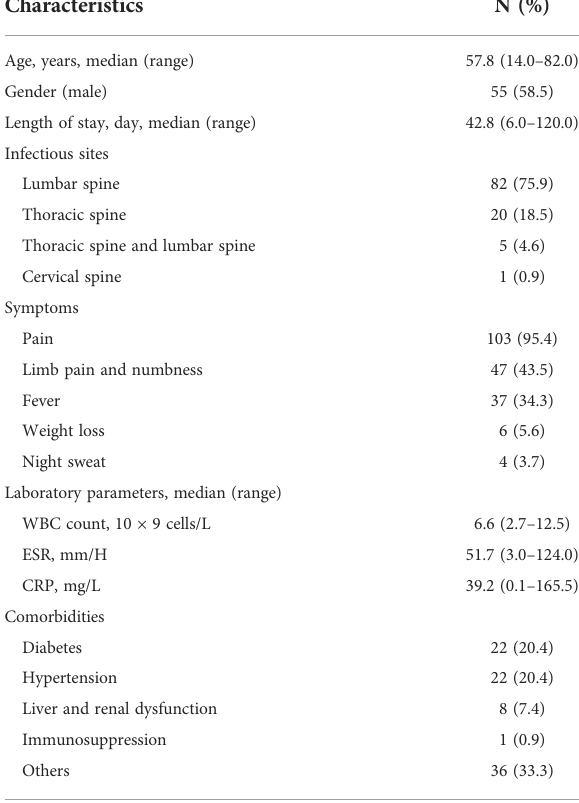
TABLE 1 Characteristics of 108 patients enrolled in this study.